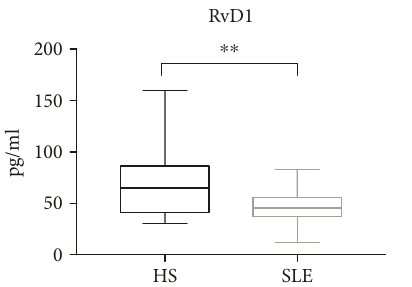
Figure 1: Levels of resolvin D1 (RvD1) in plasma from SLE patients ( n = 30 ) and matched HSs ( n = 30 ). Data are expressed as pg/ml, median (horizontal bar) with 25th and 75th percentile (boxes), and minimum and maximum (bars) ( ∗∗ p = 0 0043 ).